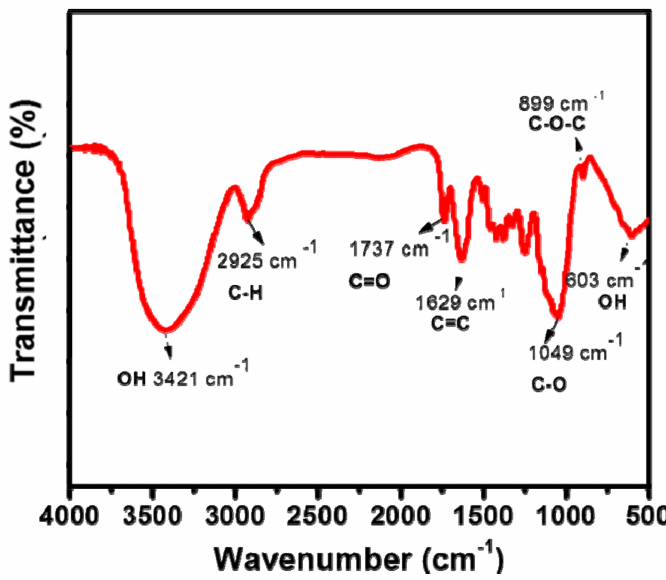
Figure 3. The FTIR spectra of abutilon